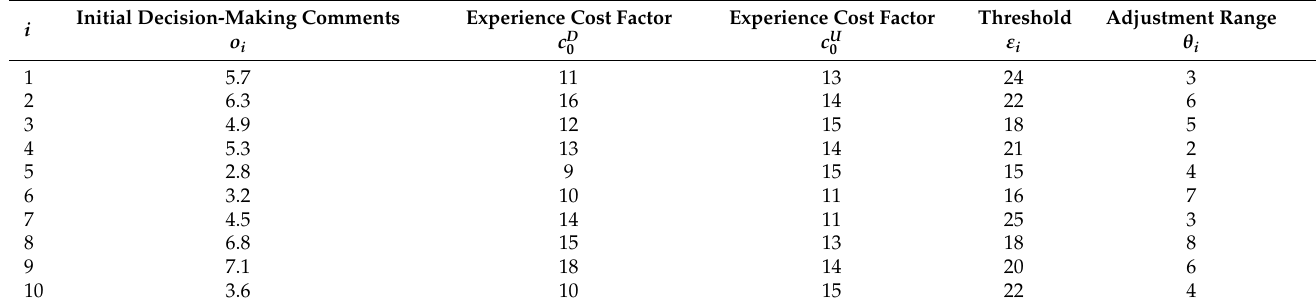
Table 1. Information data related to the DMs in the